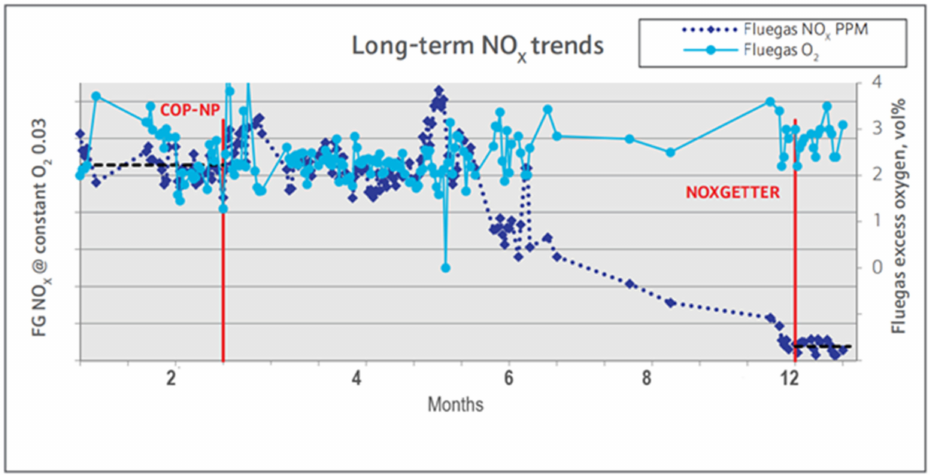
Figure 32. Time average of NOx emission at excess O 2 in the FCC regenerator. Adopted from Genç et al.